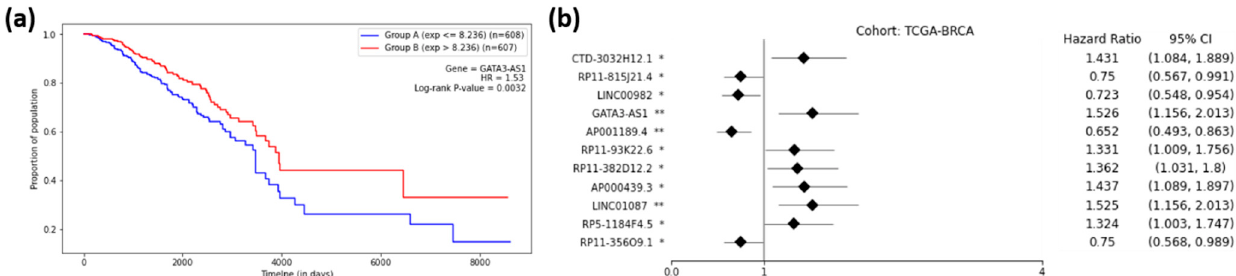
Figure 5. Survival Analysis of TCGA-BRCA. ( a ) Kaplan–Meier Curve for the GATA3-AS1 lncRNA on the TCGA-BRCA cohort. Group A (blue) is the group with an expression less than or equal to the median, and Group B (red) is the group with an expression greater than the median. ( b ) Forest plot of survival analysis for 11 prognostic lncRNAs on the BRCA cohort. The asterisks represent the log-rank p -values (*— p ≤ 0.05, **— p ≤ 0.01).